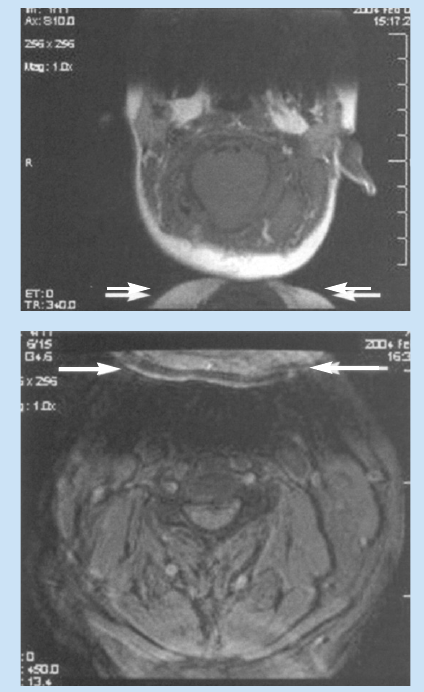
Figs 6 and 7. Wrap around artefacts.